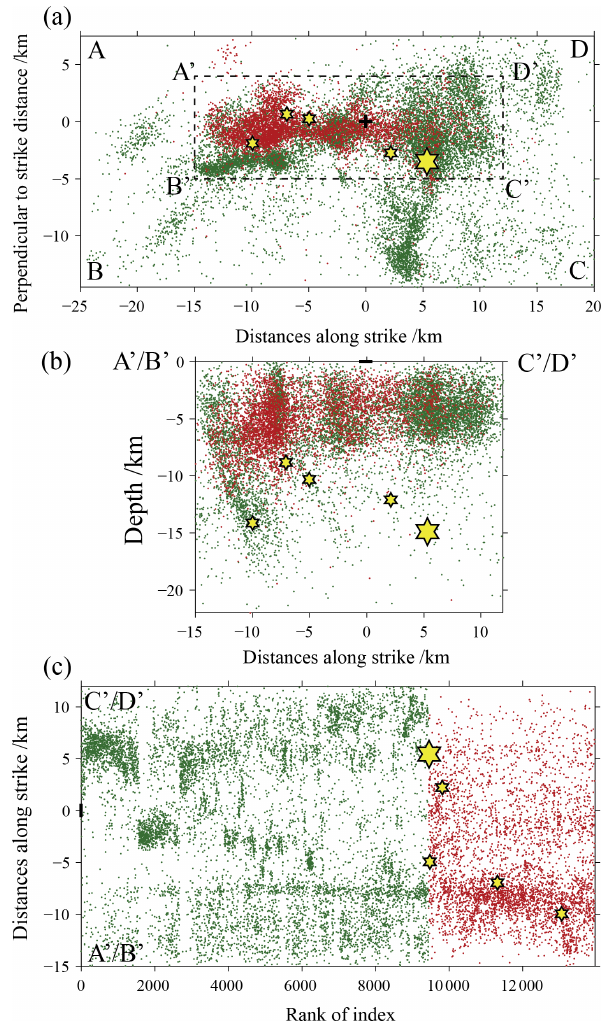
Figure 2. Distribution of seismicity for b -value calculations. (a) Ro- tation of the coordinate system to the seismic distribution along the direction of the aftershock distribution; (b) projection of the earthquakes in the rectangular frame A (cid:48) B (cid:48) C (cid:48) D (cid:48) on the depth profile; (c) the temporal and spatial distribution on the distance versus rank of index 2-D map of the earthquakes within the rectangular frame A (cid:48) B (cid:48) C (cid:48) D (cid:48) . The meaning of the symbols is the same as in Fig. 1.